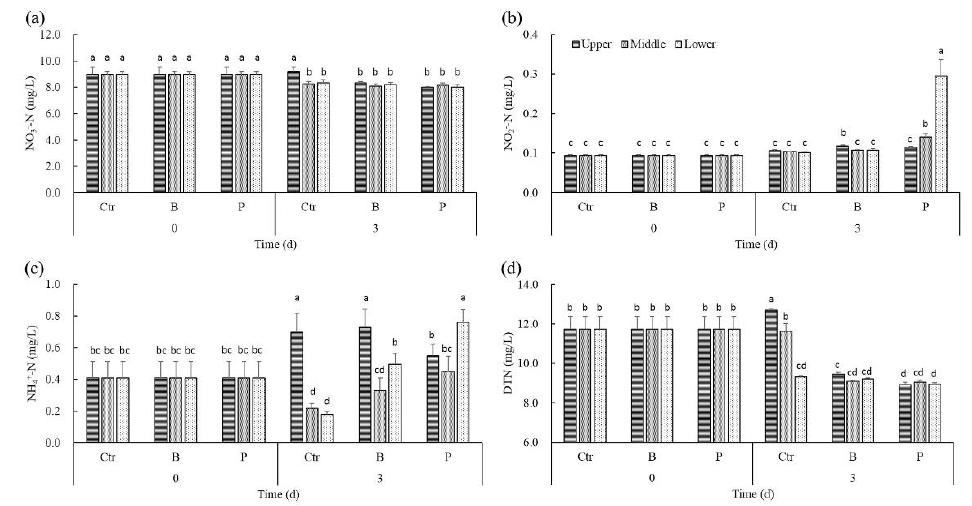
Figure 3. The effect of algicidal and denitrifying bacteria on NO 3 − -N ( a ), NO 2 − -N ( b ), NH 4+ -N ( c ) and DTN ( d ) concentrations in the different layers of water.